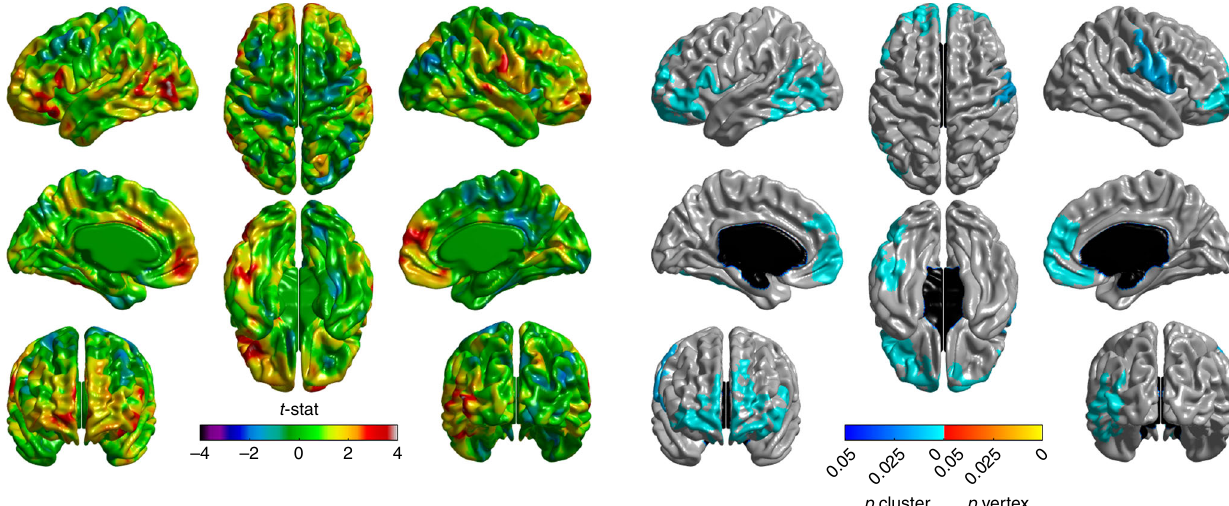
Fig. 1 Cortical thinning in PD. Changes in cortical thickness in PD patients compared to healthy controls over the 1-year study period. Left panel: t -statistic comparing PD to HC at baseline and follow-up [(PD2-PD1) – (HC2-HC1)], at each cortical vertex. Right panel: thresholded map showing areas of signi fi cant difference. Cluster-corrected p -value in blue